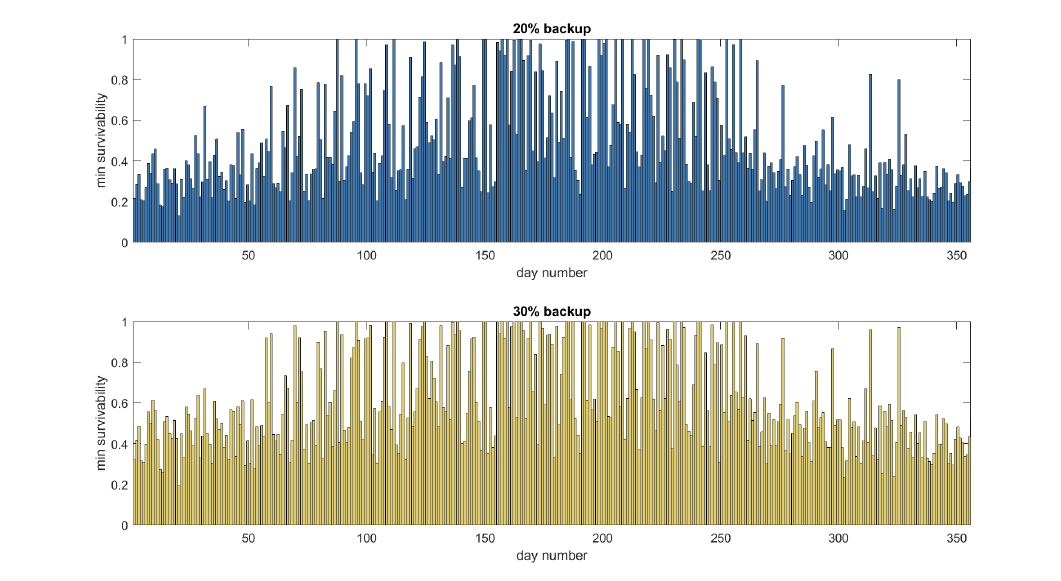
Figure 4. Minimum survivability per day for a full year with the smart strategy for 20% and 30% backup capacity,